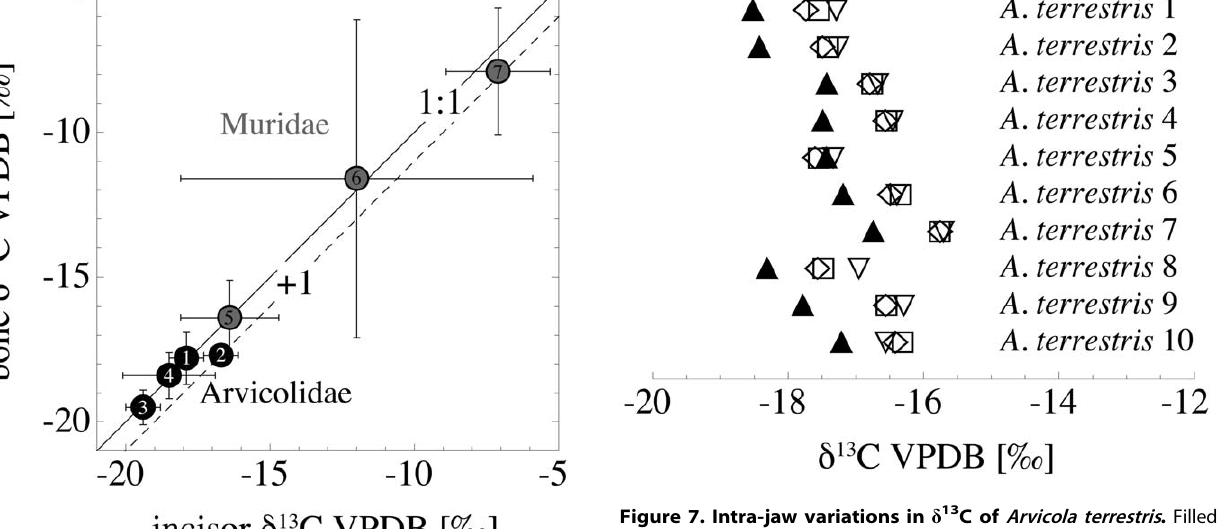
Figure 7. Intra-jaw variations in d 13 C of Arvicolaterrestris . Filled triangles=incisors, open diamonds=M1, open squares=M2, open down triangles=M3.